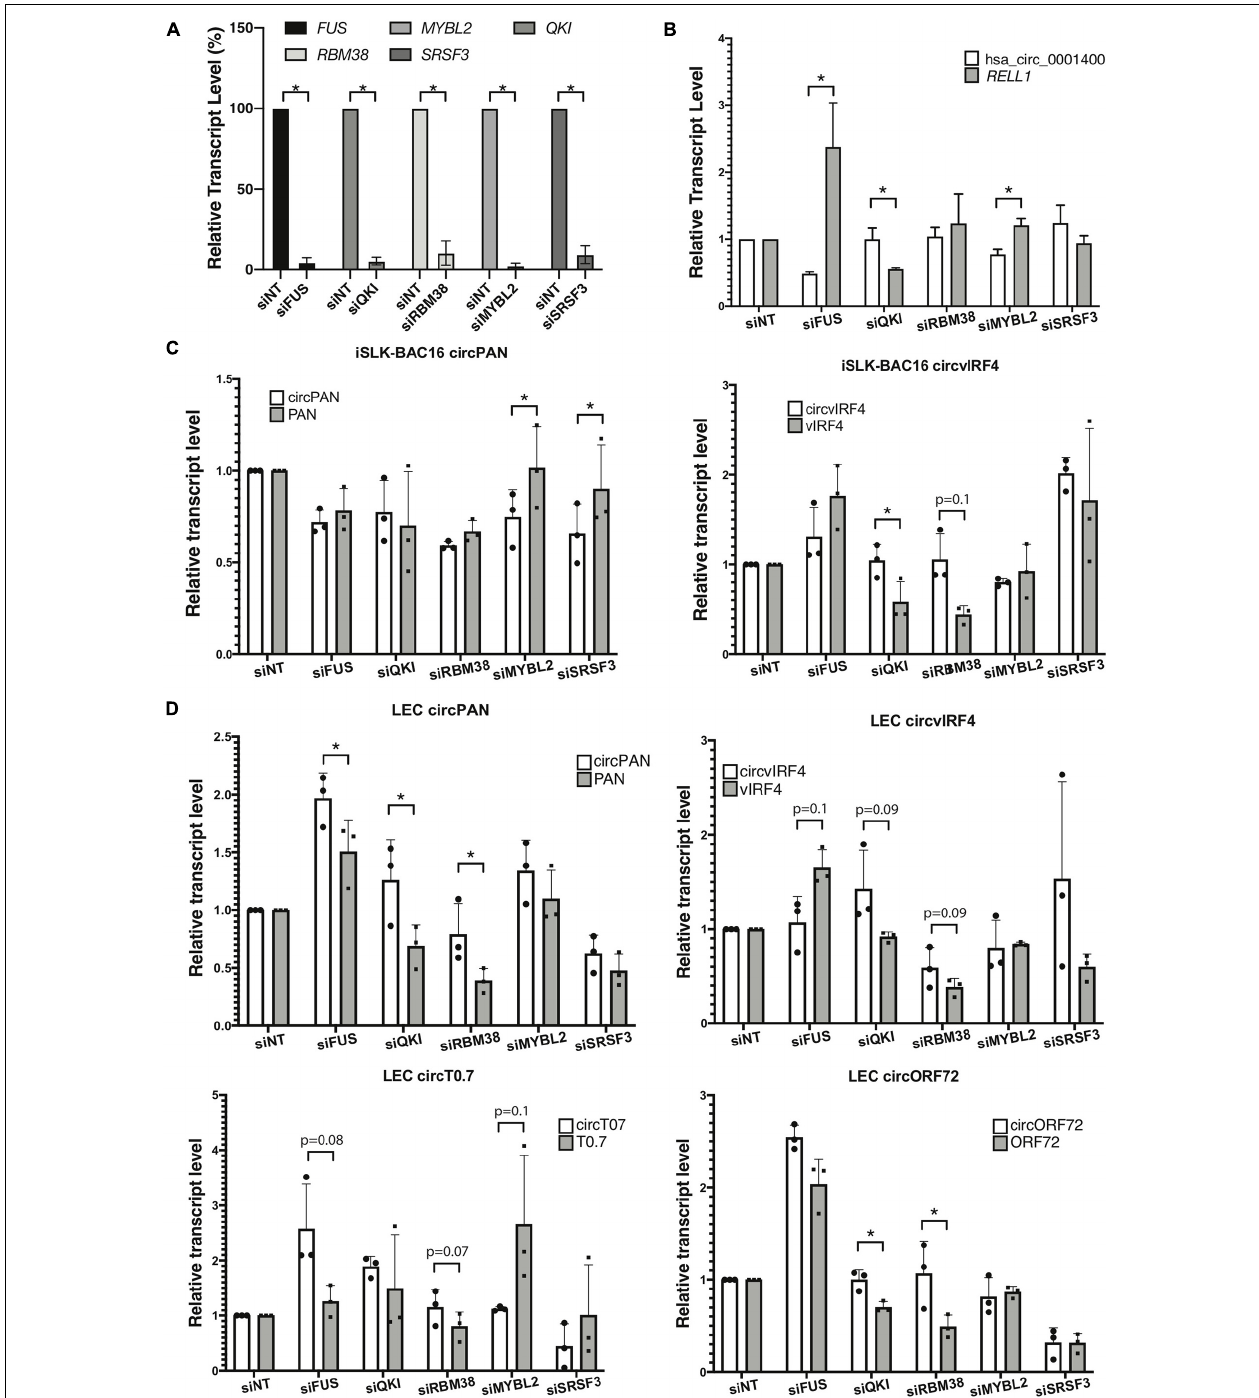
FIGURE 5 | RNA-binding proteins and production of viral circRNAs. RNA-binding proteins (RBPs) were knocked-down with siRNA pools and circular RNAs and their linear mRNAs counterparts were quantitated. (A,B) KSHV-negative SLK cells were knocked-down for RBPs and RBP-coding transcript levels ( n = 4) (A) , and hsa_circ_0001400 and RELL1 expression levels ( n = 3) (B) were quantitated with RT-qPCR. Expression levels were normalized to non-targeting siRNA (siNT) control. 18 S RNA was used as internal control. (C) iSLK-BAC16 cells were knocked-down for RBPs, reactivated for lytic cycle, and viral circRNAs and their linear counterparts were quantitated with RT-ddPCR. Absolute copy numbers were quantitated and normalized to non-targeting siRNA control. (D) Primary LECs were knocked-down for RBPs, de novo infected for 3 days at MOI of 30, and viral circRNAs and their linear counterparts were quantitated with RT-ddPCR. Absolute copy numbers were quantitated and normalized to siNT control ( n = 3). Error bars indicate standard deviation. Statistical significances were calculated by paired ratio t -test. * p < 0.05.